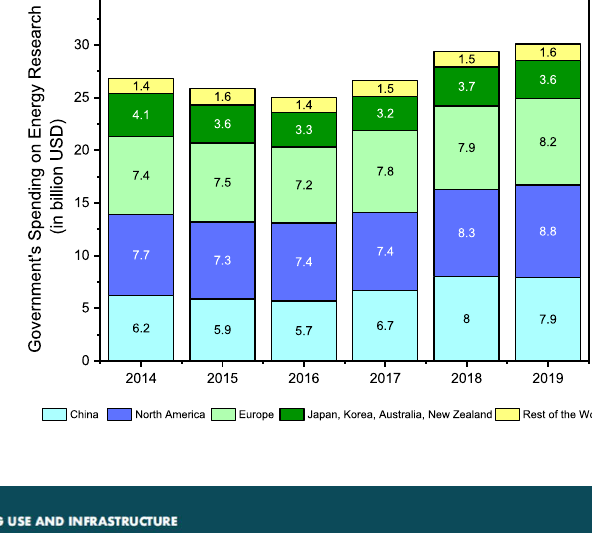
Fig. 21 Global LNG infrastruc- ture